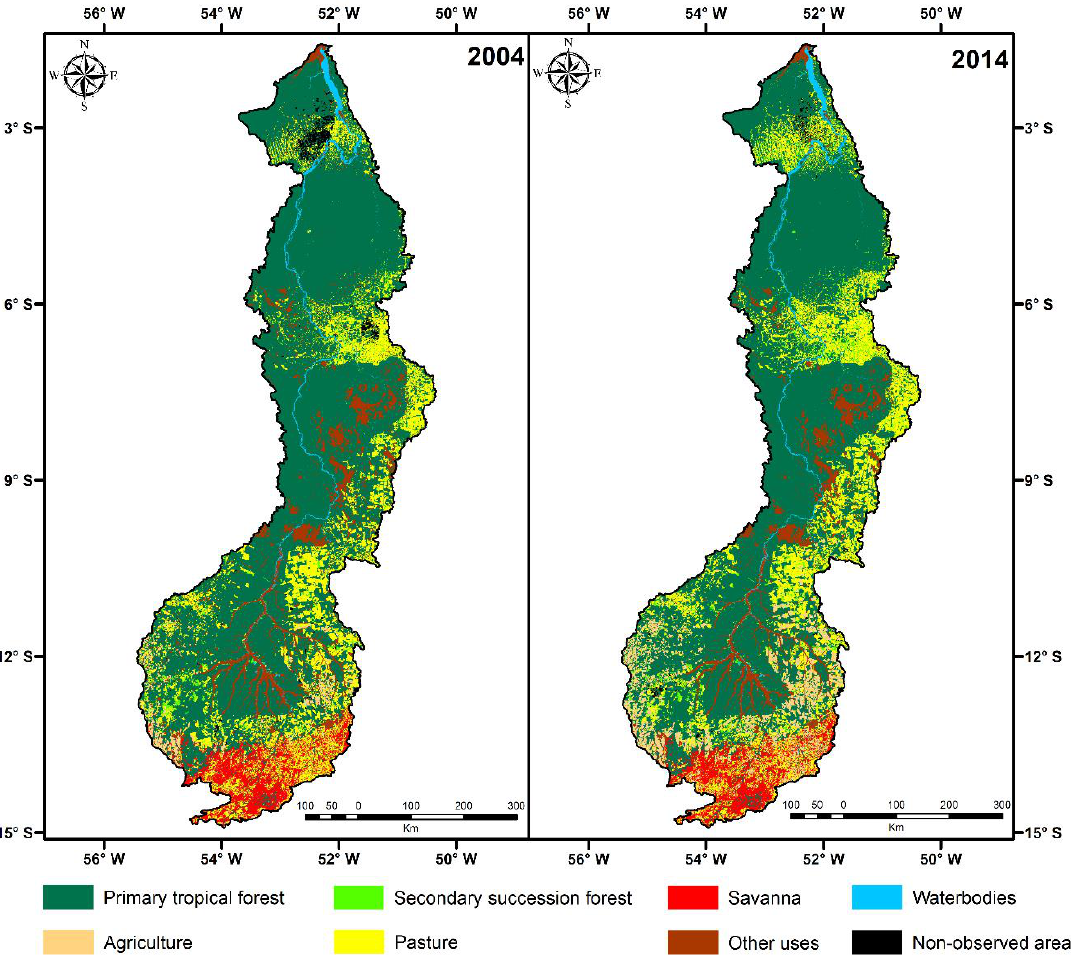
Figure 2. Land use and land cover in the Xingu River Basin for the years 2004 and 2014. Maps were generated using the TerraClass [30] and MapBiomas [31] mappings.